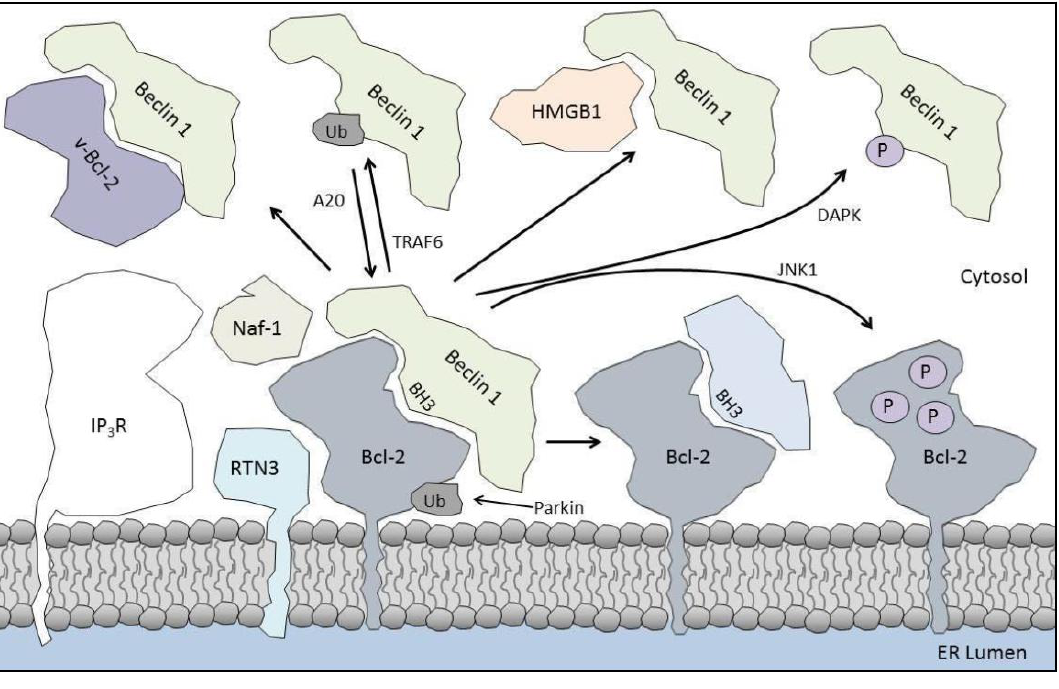
Figure 2. Regulation of the Bcl-2/Beclin 1 interaction at the ER. The Bcl-2/Beclin 1 interaction can be enhanced by RTN3, Naf-1, IP R and ubiquitination of Bcl-2 by Parkin. 3 Dissociation of Beclin 1 from Bcl-2 is promoted by BH3-only proteins binding to Bcl-2, phosphorylation of Bcl-2 by JNK1, phosphorylation of Beclin 1 by DAPK, viral Bcl-2 (v-Bcl-2) or HMGB1 binding to Beclin 1 or ubiquitination of Beclin 1 by TRAF6. The latter can be counteracted by deubiquitinating enzyme A20. See text for detailed